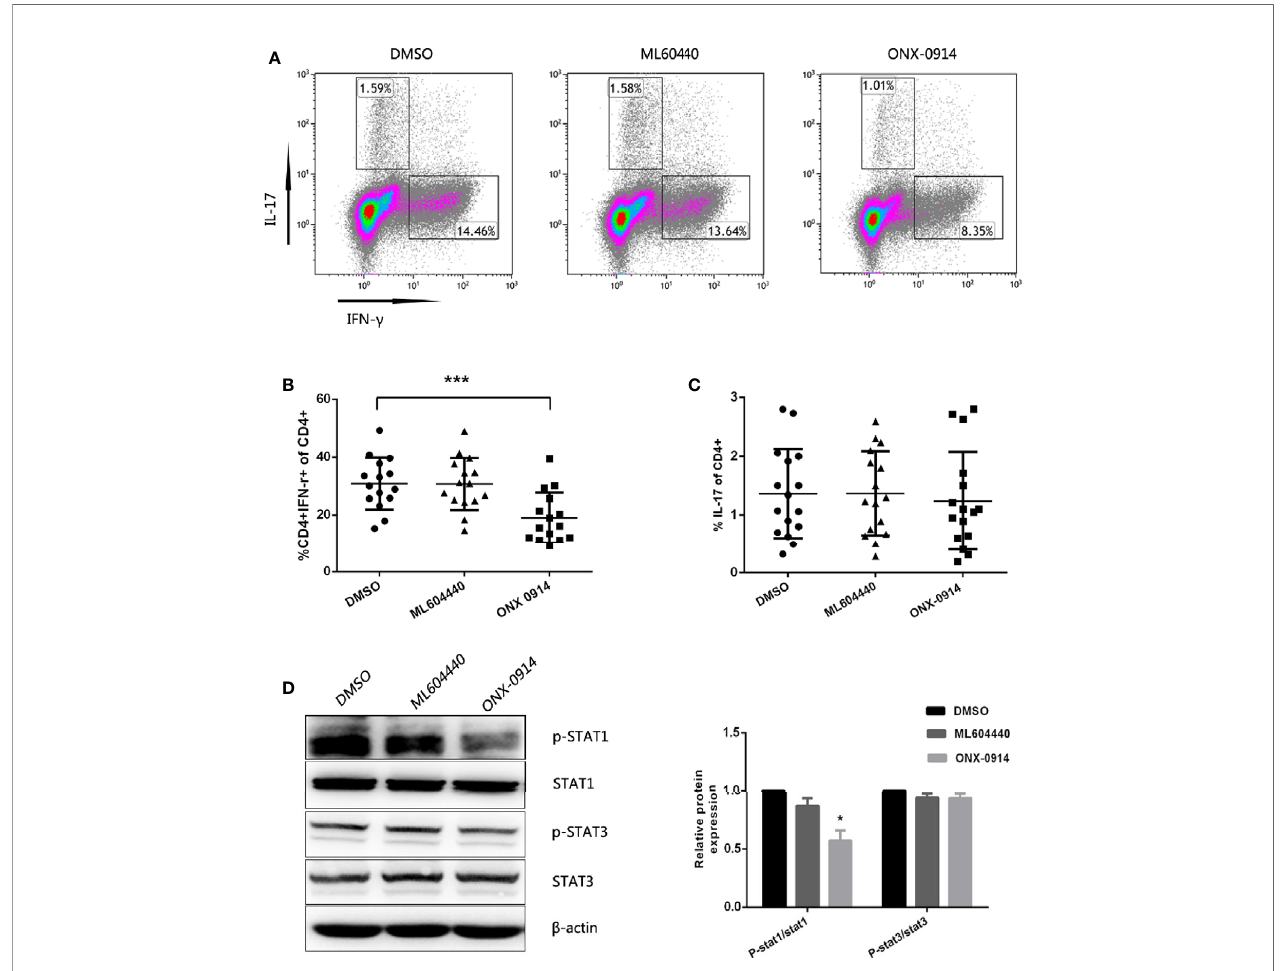
FIGURE 5 | ONX-0914 suppress differentiation of Th1. (A – C) Differentiation was measured in 3 day cultures of CD4 + T cells isolated from ITP patients that were exposed to continuous DMSO, ML604440 (300 nM), or ONX 0914 (30 nM), and that were stimulated with platelet-bound antibodies to CD3/CD28. IFN- g and IL-17 expression were detected by intracellular cytokine staining after 4 hours of restimulation with PMA/ionomycin/BFA. Values re fl ect percentage of CD4 + cells that were IFN- g + or IL-17A + . All data were statistically compared to DMSO-treated group. ***P < 0.001. One-way ANOVA. (D) Western blot of puri fi ed CD4 + T cells that were cultured for 3 days with anti-CD3/CD28 in the presence or absence of ML604440 (300 nM) or ONX 0914 (30 nM). Data are representative of at least three independent experiments. *P < 0.05 vs